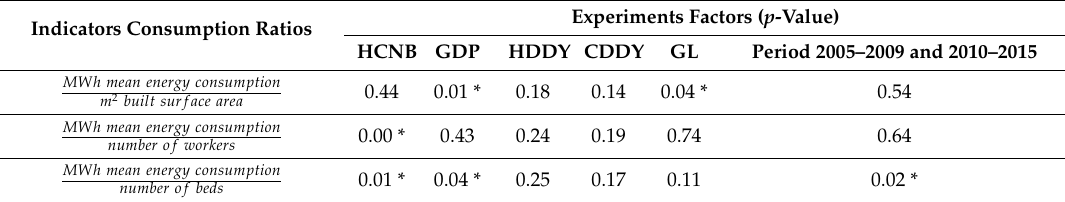
Table 2. Results for the p- value corresponding to the analysis of variance (ANOVA) for the average annual energy consumption.